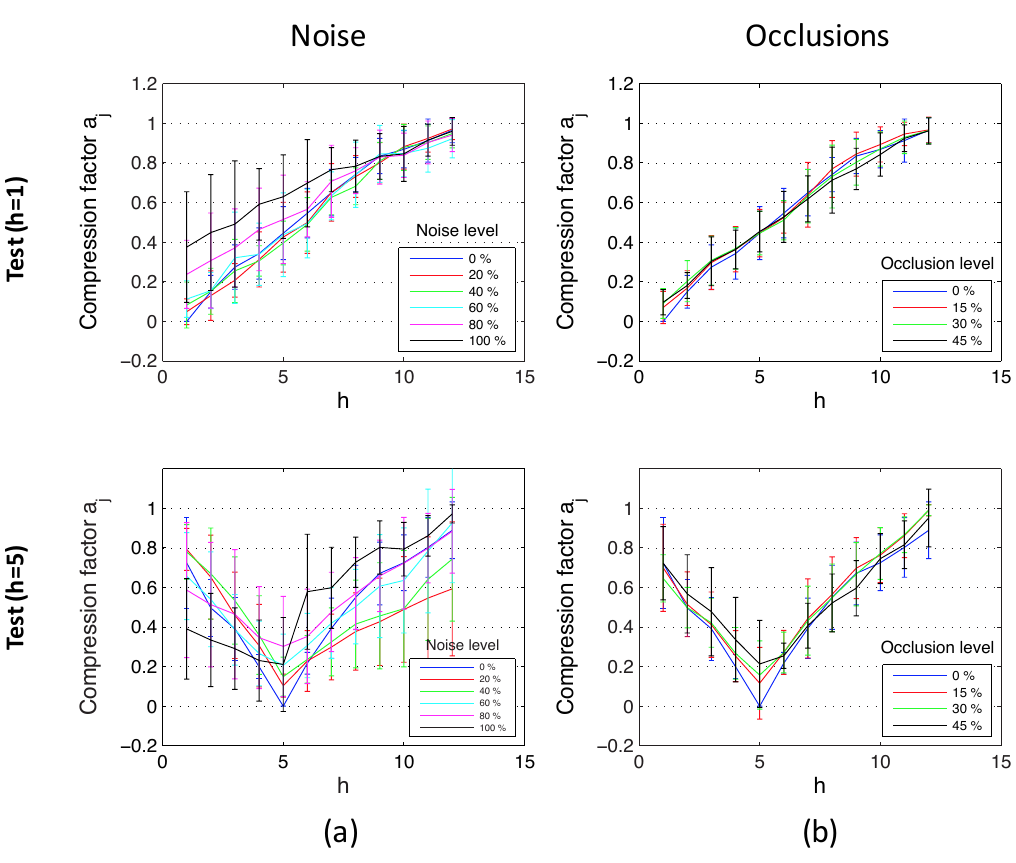
Figure 16. Altitude estimation using the database captured in outdoor environments, using reference images at the bottom (h = 1) and in the middle of the height (h = 5). Average and standard deviation of all locations considering ( a ) noise added to the test images and ( b ) occlusions added to the test